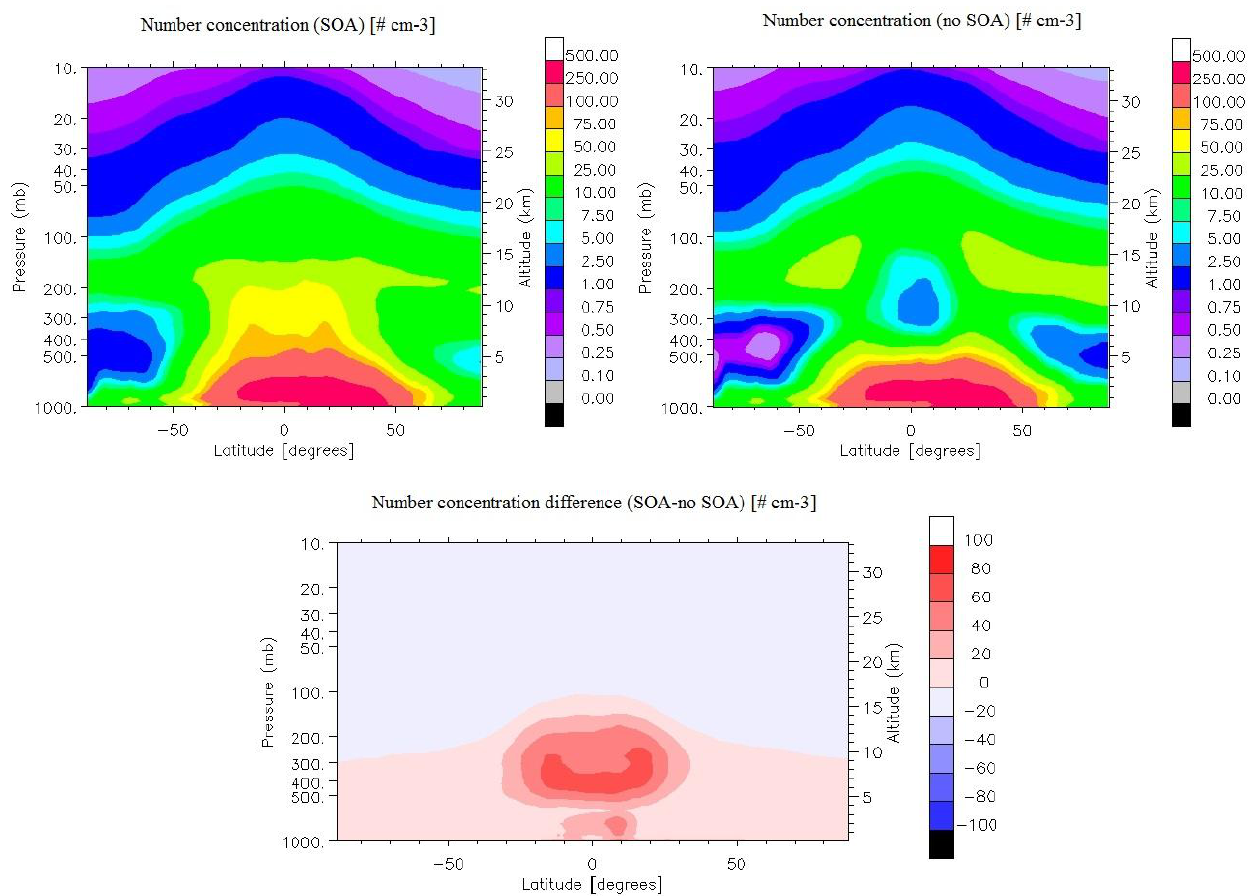
Fig. 7. Accumulation soluble mode number concentration (# cm − 3 ) with SOA (above left), without SOA (above right) and the difference Figure 7. Accumulation soluble mode number concentration (# cm -3 ) with SOA (above left), without SOA (above right) and the difference (below).